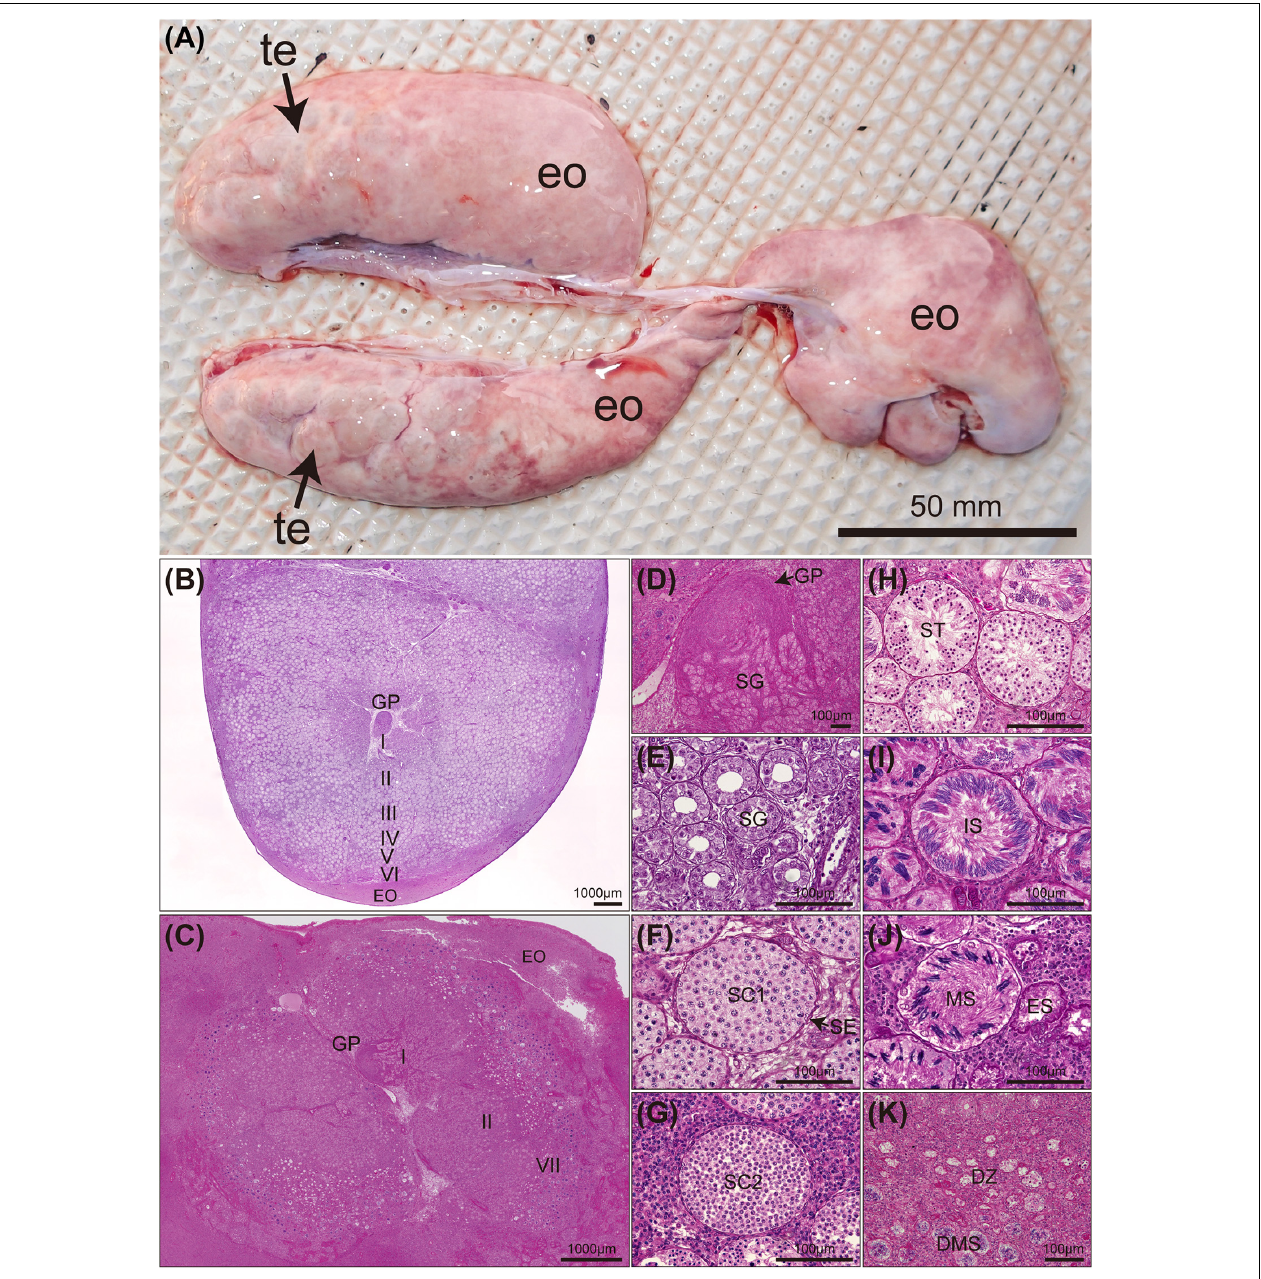
FIGURE 4 | Mature Aetobatus narutobiei testes anatomy and stages of spermatogenesis (A) (te) testis lobe, (eo) epigonal organ and histology (B–K) . (B) Cross section through a single testicular lobe with germinal papilla (GP) and epigonal organ (EO) (August). (C) Cross section through a single testicular lobe (October). (D) Stage I primary spermatogonia (SG). (E) Stage II early spermatocysts with spermatogonial cells (SG). (F) Stage III primary spermatocytes (SC1) with sertoli cells (SE). (G) Stage III secondary spermatocytes (SC2). (H) Stage IV spermatids (ST). (I) Stage V immature sperm (IS). (J) Stage VI mature sperm (MS) and an empty spermatocyst (ES). (K) Stage VII degenerate zone (DZ) and degenerate mature sperm